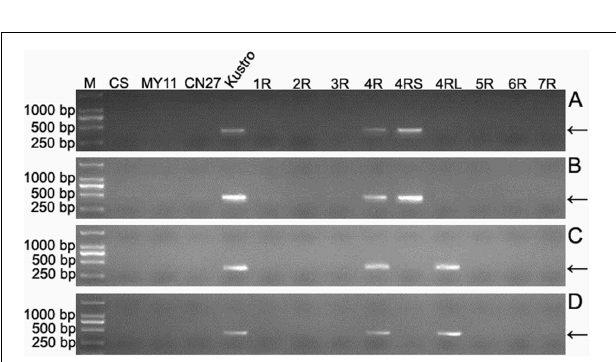
FIGURE 3 | Identification of 4R Ku -specific, 4RS Ku -specific and 4RL Ku -specific markers using CS, MY11, CN27, Kustro, MTA4RS Ku , MTA4RL Ku and MA1R Ku –7R Ku . (A) Products amplified by primer pair KU-4R.429. (B) Products amplified by primer pair KU-4R.732. (C) Products amplified by primer pair KU-4R.012. (D) Products amplified by primer pair KU.170. Primer pairs KU-4R.429 and KU-4R.732 represent the 4RS Ku -specific markers. Primer pairs KU-4R.012 and KU.170 represent the 4RL Ku -specific markers. M: DNA marker. CS: Chinese Spring. MY11: Mianyang 11. CN27: